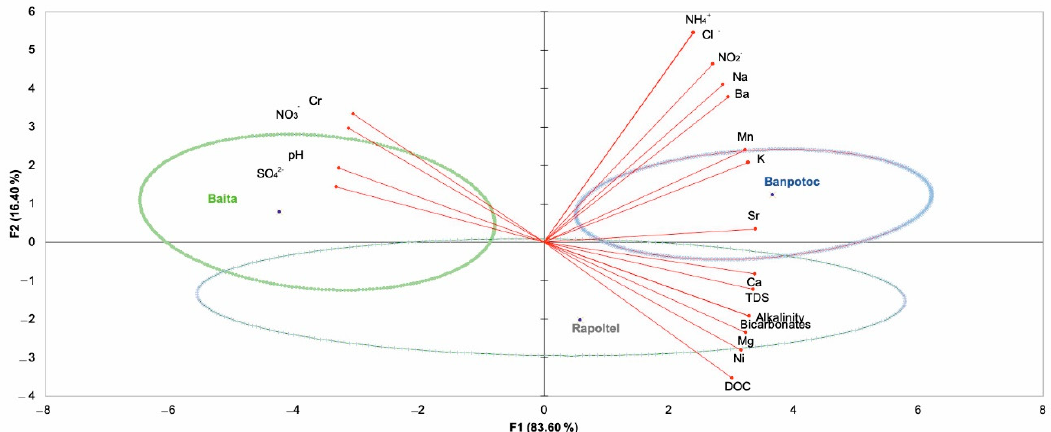
Figure2. ThePCAoftherelationshipbetweenthethreespringsandtheirphysicochemicalcharacteristics Figure 2. The PCA of the relationship between the three springs and their physicochemical (see also Table characteristics (see also Table 2).